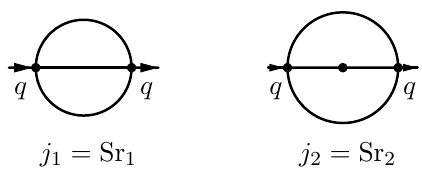
Figure 1 . The sunrise